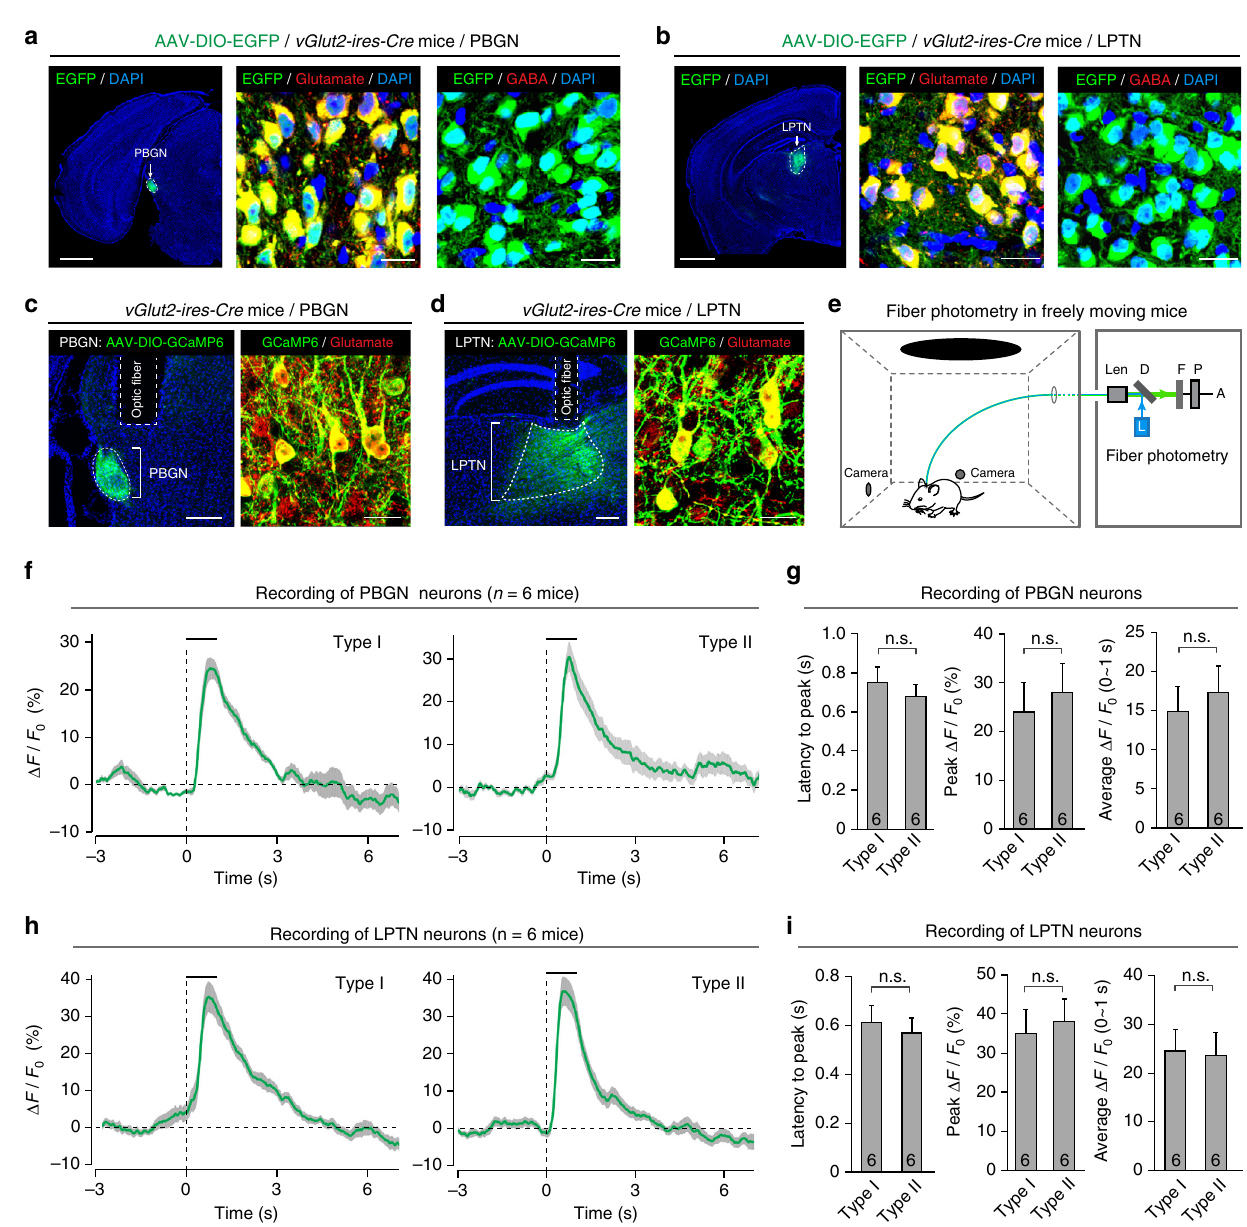
Fig. 6 Glutamatergic neurons in the PBGN and LPTN respond to looming visual stimuli. a , b AAV-DIO-EGFP was injected into the PBGN ( a , left) and LPTN ( b , left) of vGlut2-ires-Cre mice, resulting in EGFP expression in glutamate + neurons in the PBGN ( a , middle) and LPTN ( b , middle). Note there were almost no GABA + neurons in the PBGN ( a , right) or LPTN ( b , right). Scale bars, 1 mm (left) and 25 μ m (middle, right) for ( a ) and ( b ). c , d Example coronal sections with optic fi ber tracks above the PBGN ( c , left) and LPTN ( d , left), and micrographs showing speci fi c expression of GCaMP6 in glutamate + neurons in the PBGN ( c , right) and LPTN ( d , right). Scale bars, 0.2 mm (left) and 30 μ m for both ( c ) and ( d ). For single-channel micrographs and quantitative analyses, see Supplementary Fig. 7c − f. e Schematic diagram showing recording of Ca 2 + transients from freely moving mice in response to looming visual stimulation. f , h Averaged peri-stimulus time course of Ca 2 + transients from PBGN ( f , n = 6 mice) and LPTN neurons ( h , n = 6 mice) of freely moving mice exhibiting Type I (left) and Type II (right) defensive behavioral patterns in response to one cycle of looming stimulation (horizontal bar). Cloudy area indicates SEM of the averaged data. g , i Quantitative analyses of latency to peak (left), peak Δ F / F 0 (middle), and average Δ F / F 0 of calcium transients (right) during visual stimulation from PBGN ( g ) and LPTN neurons ( i ). Data in ( g , i ) are means± SEM (error bars). Numbers of mice are indicated in the bars. Statistical analysis was Student ’ s t test (n.s. P > (Fig. 8h). These data suggest that the PBGN and LPTN mutually increased the intrinsic excitability of PBGN or LPTN neurons compete for the dominance of behavioral outcome of Type I and (Fig. 9). NaChBac, a bacterial voltage-dependent sodium channel, II patterns in response to looming visual stimuli. has an activation threshold more negative than that of native sodium channel in neuron 46 . This property has made it a tool to manipulate neuronal excitability in mice 47 . We bilaterally injected Effects of selective exciting PBGN and LPTN neurons . To AAV-DIO-EGFP-2A-NaChBac into the PBGN or LPTN of further examine how the PBGN and LPTN coordinately control vGlut2-ires-Cre mice, resulting in expression of EGFP in PBGN the generation of dimorphic defensive behaviors, we selectively